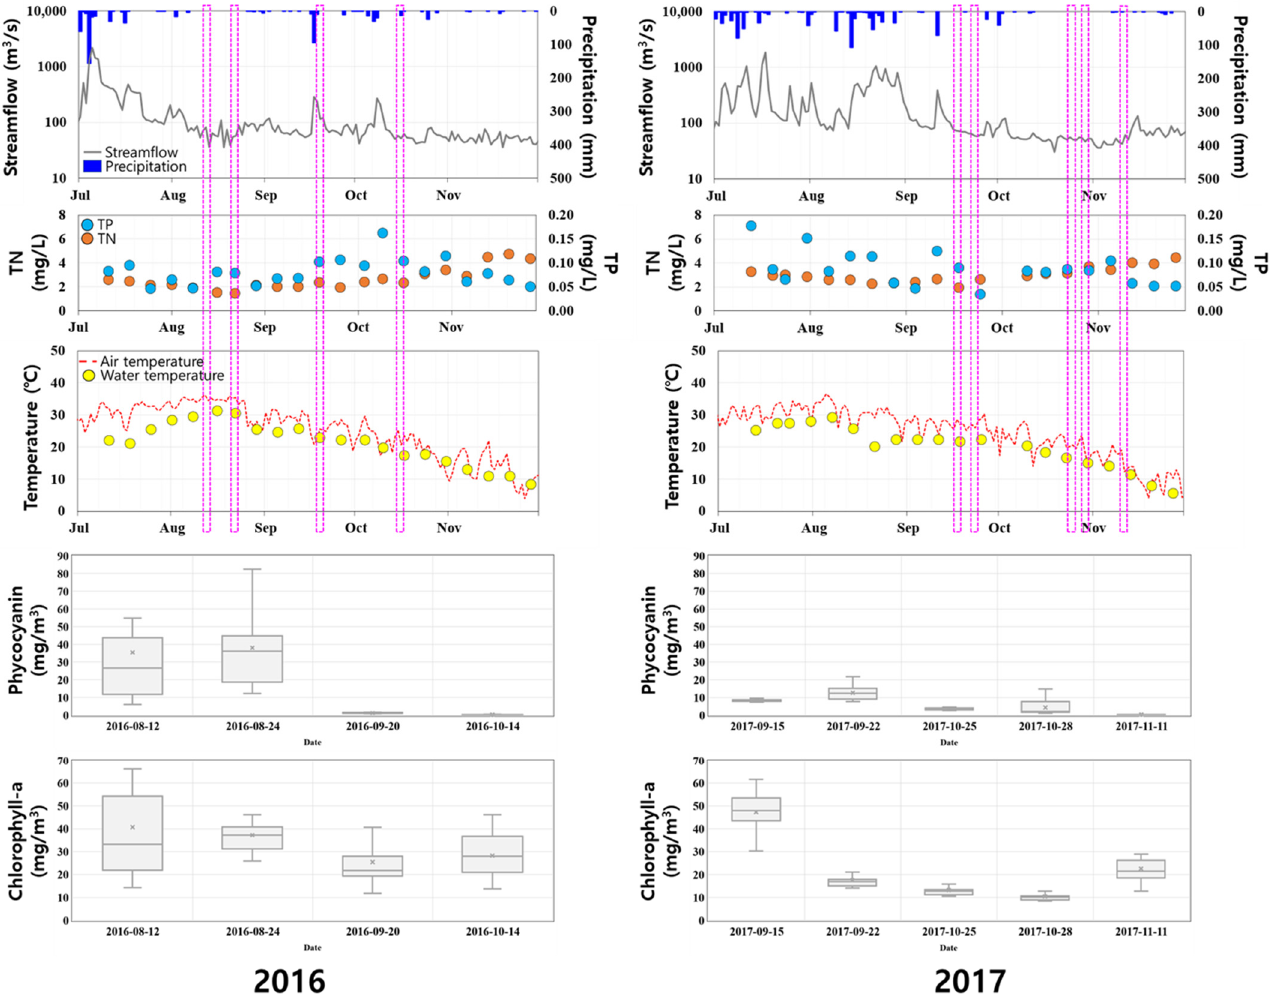
Figure A1. Temporal variations in streamflow; Total nitrogen (TN): Total phosphorus ratio (TP). TN and TP concentrations in air, and water temperatures during the 2016 to 2017 period; the nine sampling dates are indicated by magenta rectangles; PC and Chl-a concentration box plot of each sampling date.